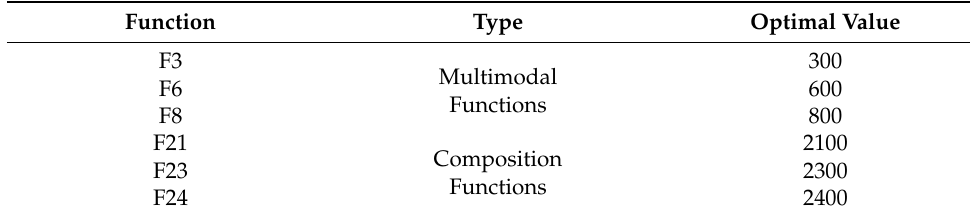
Table 1. CEC2017 test functions.